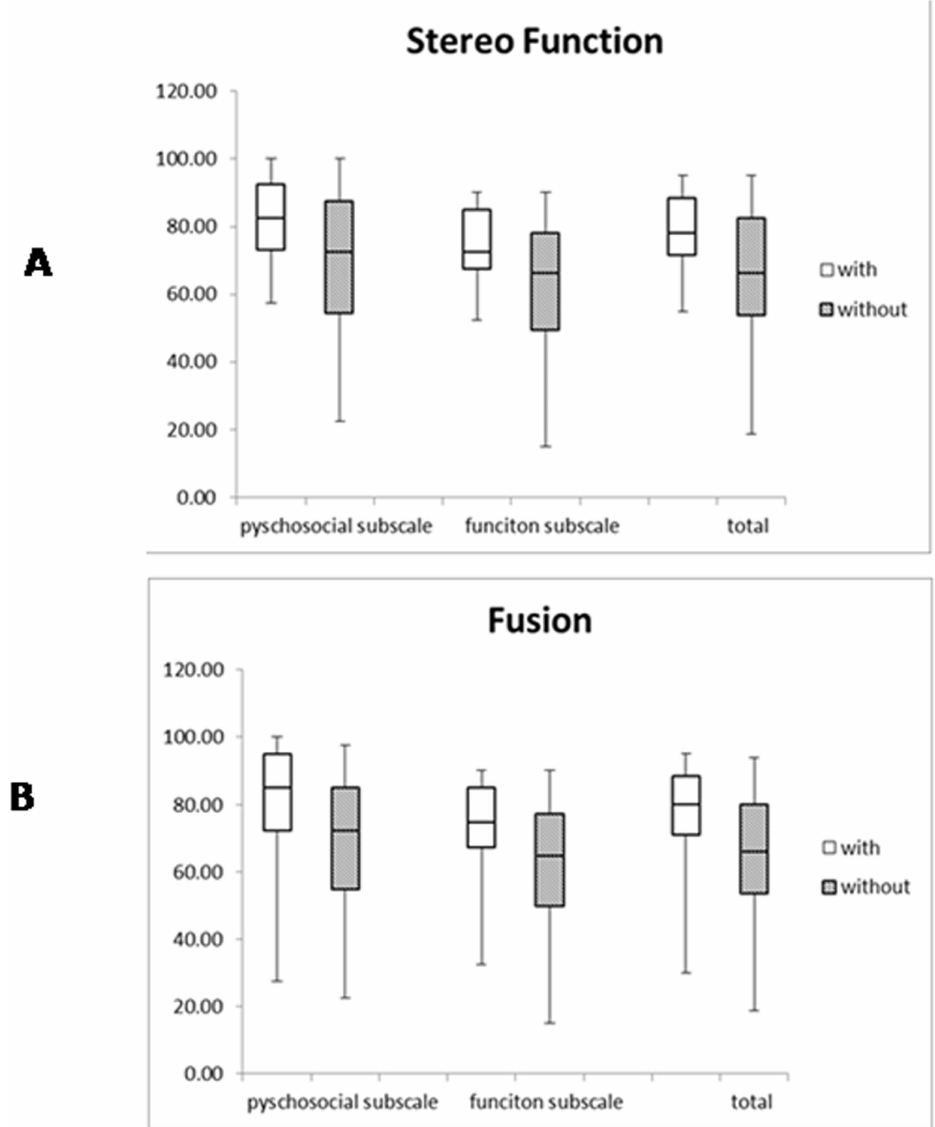
Fig 2. Comparison of binocular function scores between subjects. A: With stereo function and without stereo function, B: With fusion and without fusion.